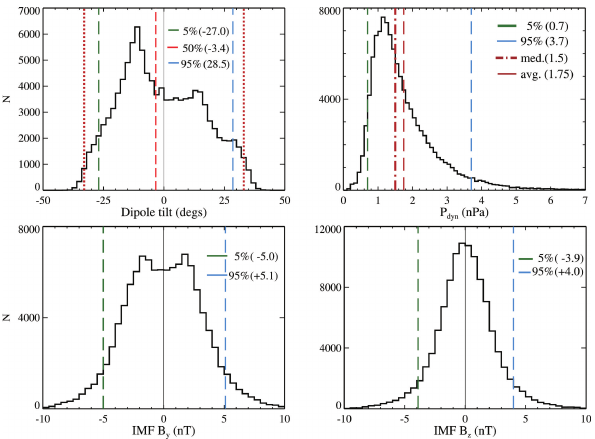
Figure 2. Histograms of the dipole tilt angle (cid:57) (top left), solar wind ram pressure P dyn (top right), IMF B y (bottom left), and IMF B z (bottom right), corresponding to the subset of equatorial current sheet crossings shown in Fig. 1. The colored dashed lines show the 5%, median, average, and 95% values as explained in legends. Red dotted lines in the (cid:57) histogram show the limiting values ± 33 ◦ , cor- responding to the standard geocentric solar magnetospheric (GSM) coordinate system (see text for details).